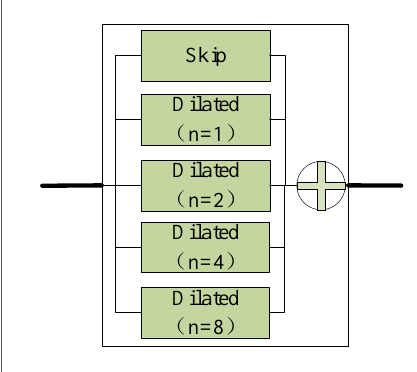
Figure 4. The Dilate network. The Dilated network consists of skip layer and four dilated convolution layer; all five layers are